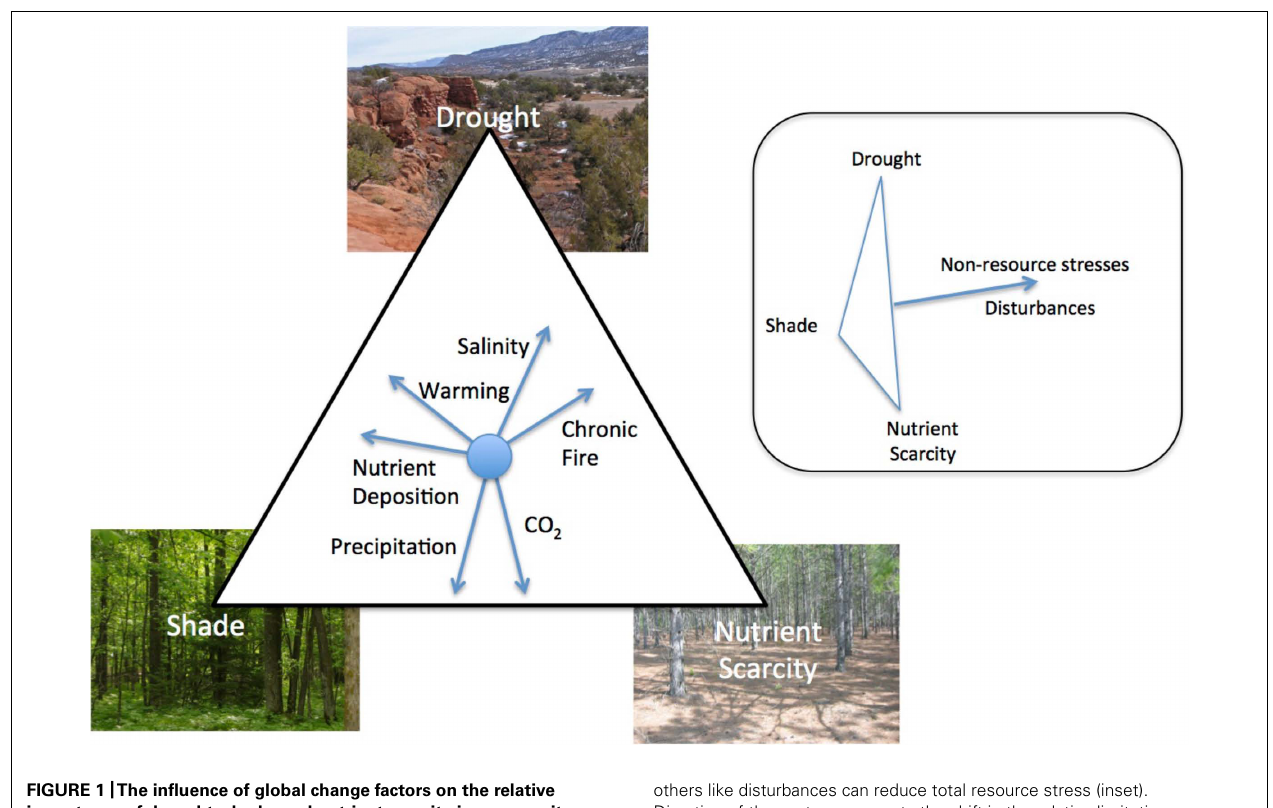
others like disturbances can reduce total resource stress (inset). Direction of the vector represents the shift in the relative limitation of different resources associated with an increase in the importance of that